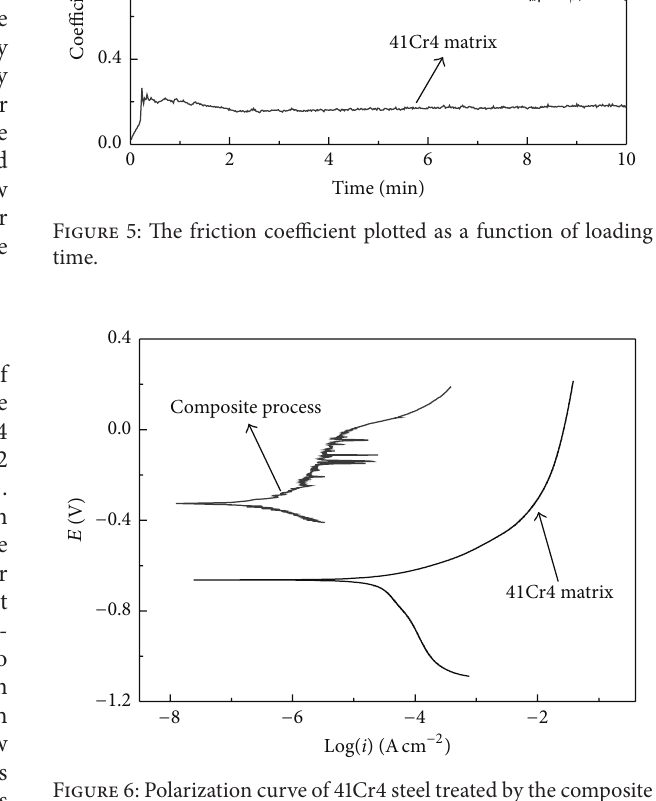
Figure 6: Polarization curve of 41Cr4 steel treated by the composite